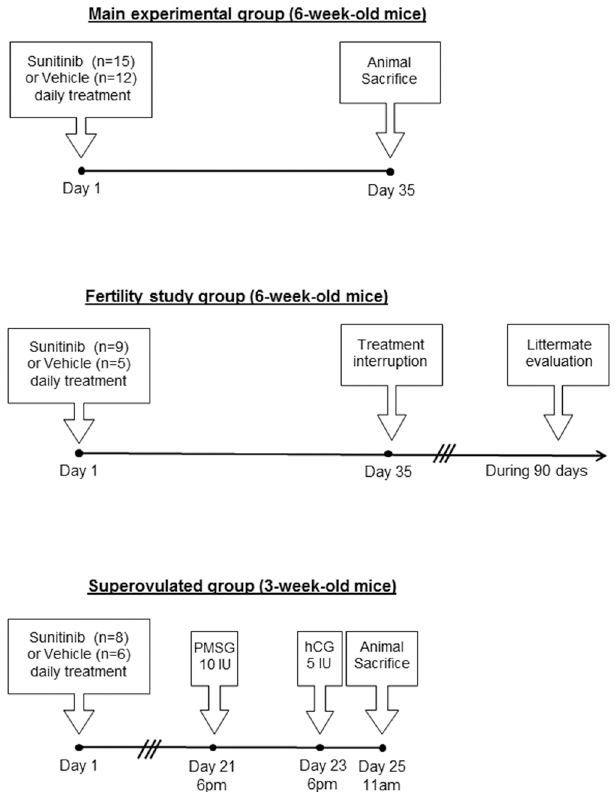
Fig 1. Study design. Six-week-old female mice received [ per os , once daily (5d/wk)] either sunitinib (n = 19) or vehicle (n = 12) during 5 weeks, and were sacrificed at day 35. Another group of 5-weeks-sunitinib (n = 9) or vehicle-treated (n = 5) mice were mated immediately after treatment withdrawal at Day 35 in order to study their fertility. A third group of 3-week-old female mice received sunitinib (n = 8) or vehicle (n = 6) during three weeks, and then were superovulated by intraperitoneal injection of 10 IU pregnant mare ’ s serum gonadotropin (PMSG) at 6pm, followed by intraperitoneal injection of 5 IU human Chorionic Gonadotropin (hCG) 48 h later. Animals were killed 17 h after the hCG